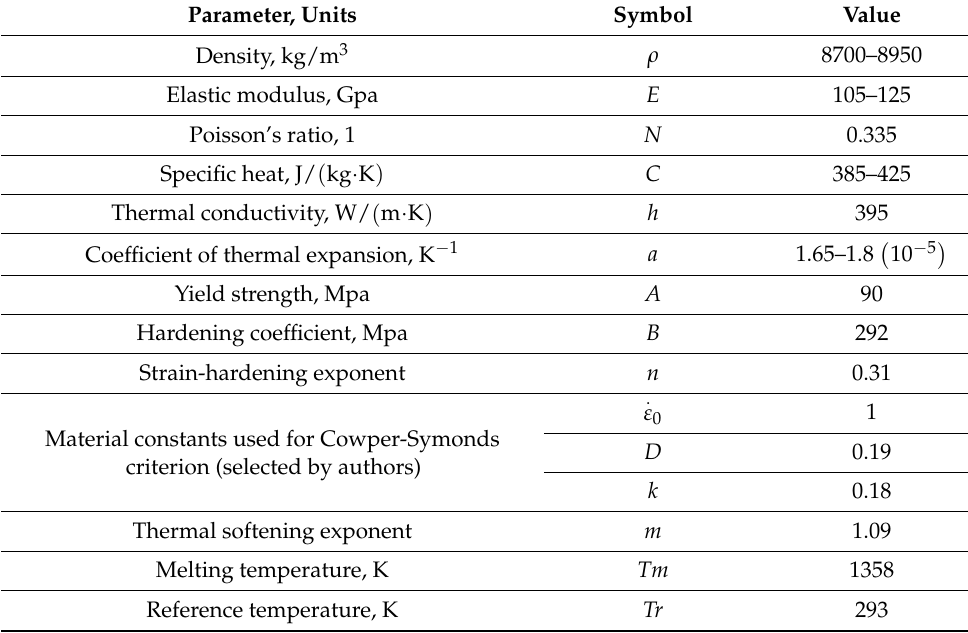
Table 4. Copper material